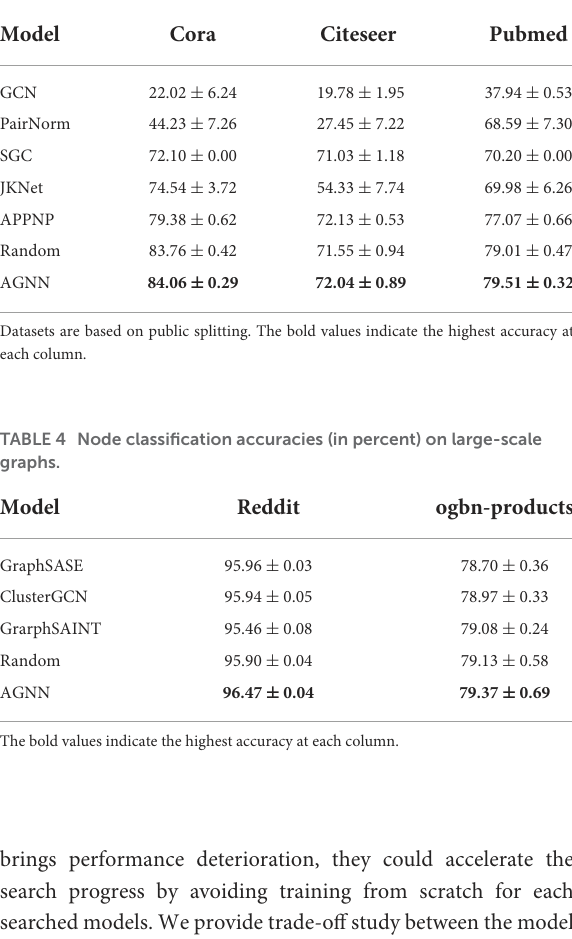
TABLE 3 Classification accuracy (in percent) of 16-layer GNNs.